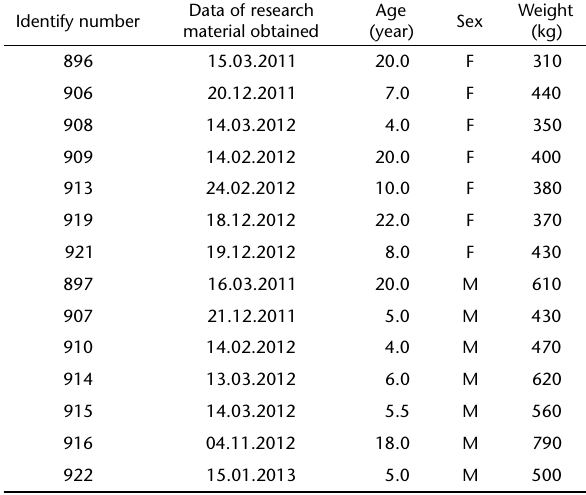
Table 1. Characteristic of European bison with respect age, sex and